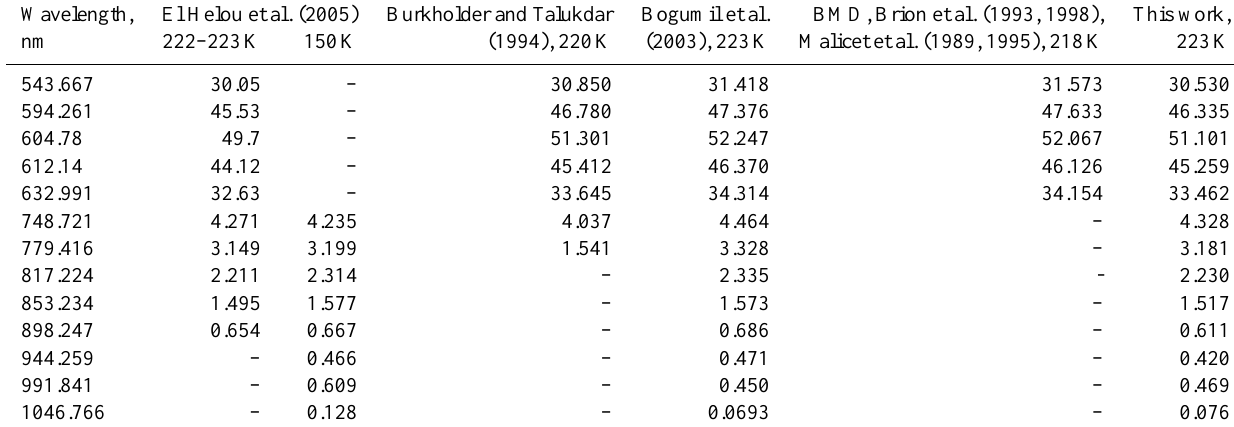
Table 4. Comparison of some ozone cross-section datasets at low temperatures in the Chappuis and Wulf bands, × 10 − 22 cm 2 molecule − 1 . Wavelength, El Helou et al. (2005)